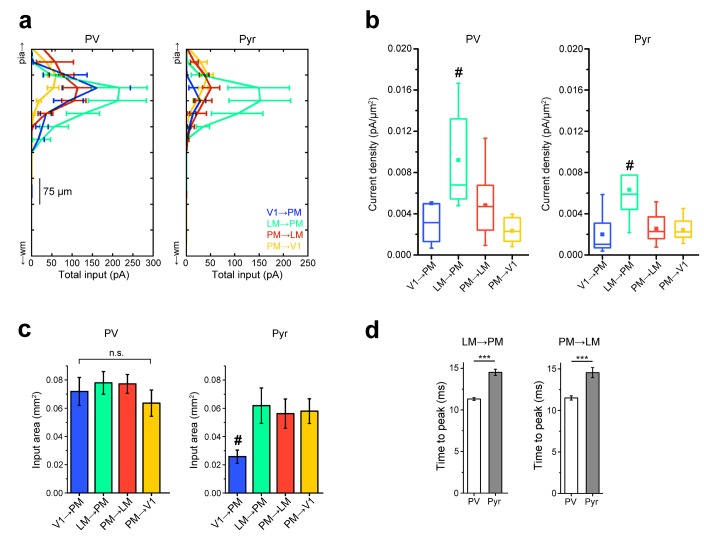
Comparisons of strengths, extent, and rise times of inputs in L2/3 pathways.(a) Total EPSC per row plotted against row position for L2/3 PV and Pyr cells in the FFV1→PM, FFLM→PM, FBPM→LM and FBPM→V1 pathways. Strongest EPSCs in both cell types are observed in the LM→PM pathway, with weak EPSCs to Pyr cells in the FFV1→PM pathway. (b) FFLM→PM inputs result in the strongest current density (measured as EPSC/pixel, converted to pA/µm [Coogan and Burkhalter, 1993]) among all examined L2/3 pathways for both PV and Pyr cells (#p<0.05 against each of the other three pathways) (c) The total area over which individual PV cells receive input is not significantly different for PV cells. Pyr cells in the FFV1→PM pathway receive input over the smallest area (#p<0.05 against each of the other pathways). (d) The mean time to peak for interareal EPSCs is smaller in PV than in Pyr cells in both FFLM→PM and FBPM→LM pathways.